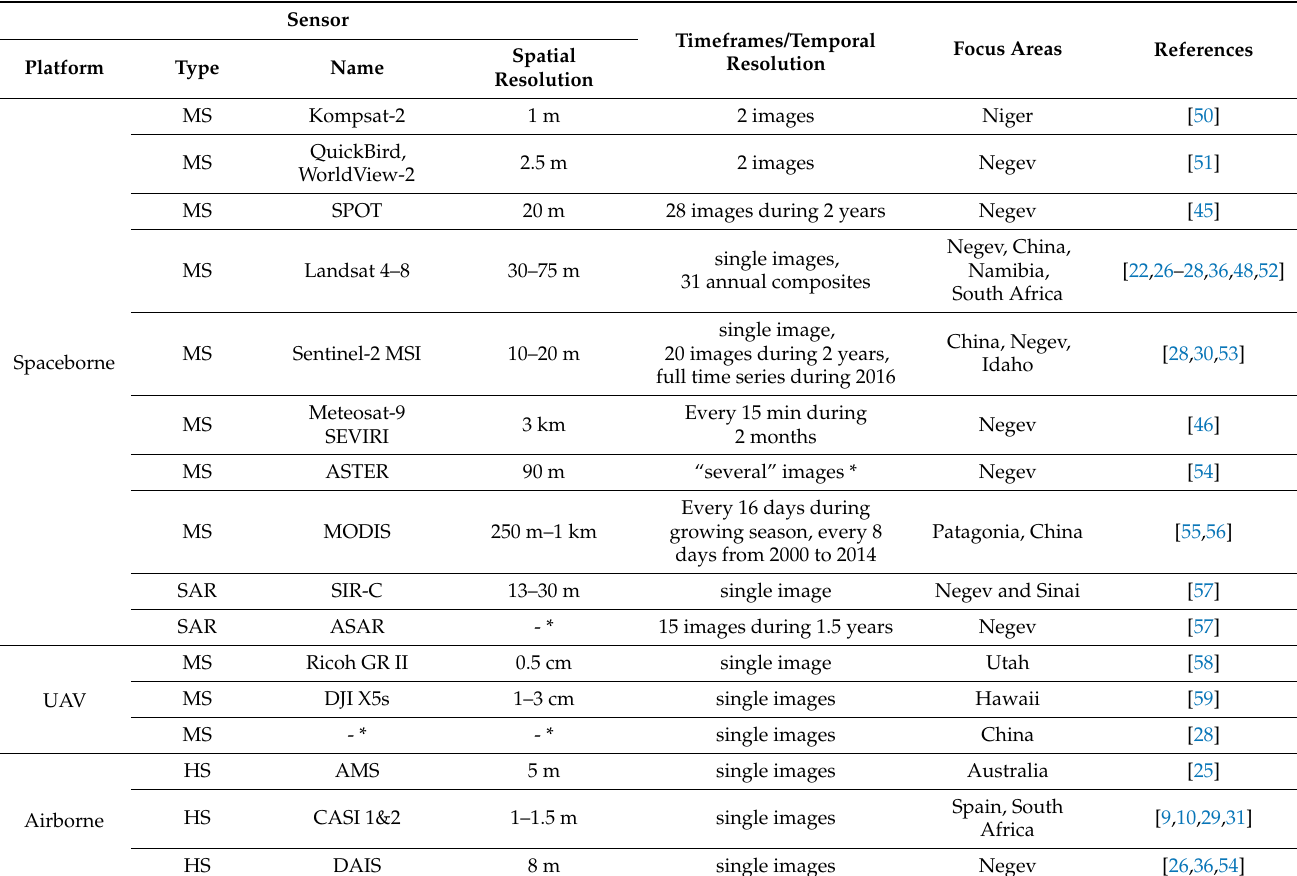
Table 1. Remote sensing sensors used for characterizing and mapping biological soil crusts with the corresponding studies’ timeframes and focus areas. MS = multispectral, HS = hyperspectral, UAV = unmanned airborne vehicle, SAR = synthetic aperture radar. * not